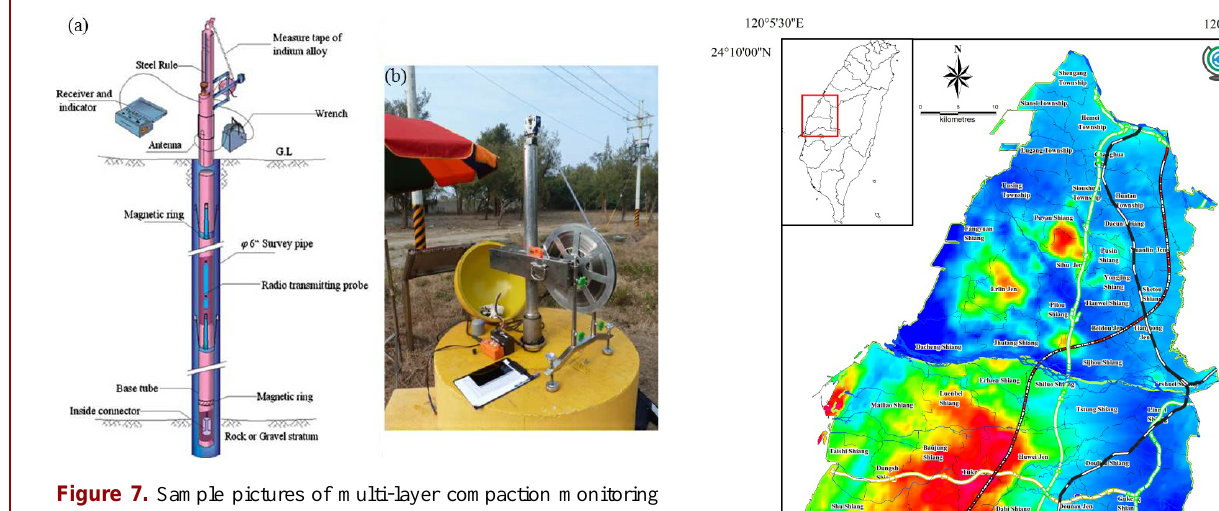
Figure 7. Sample pictures of multi-layer compaction monitoring well.